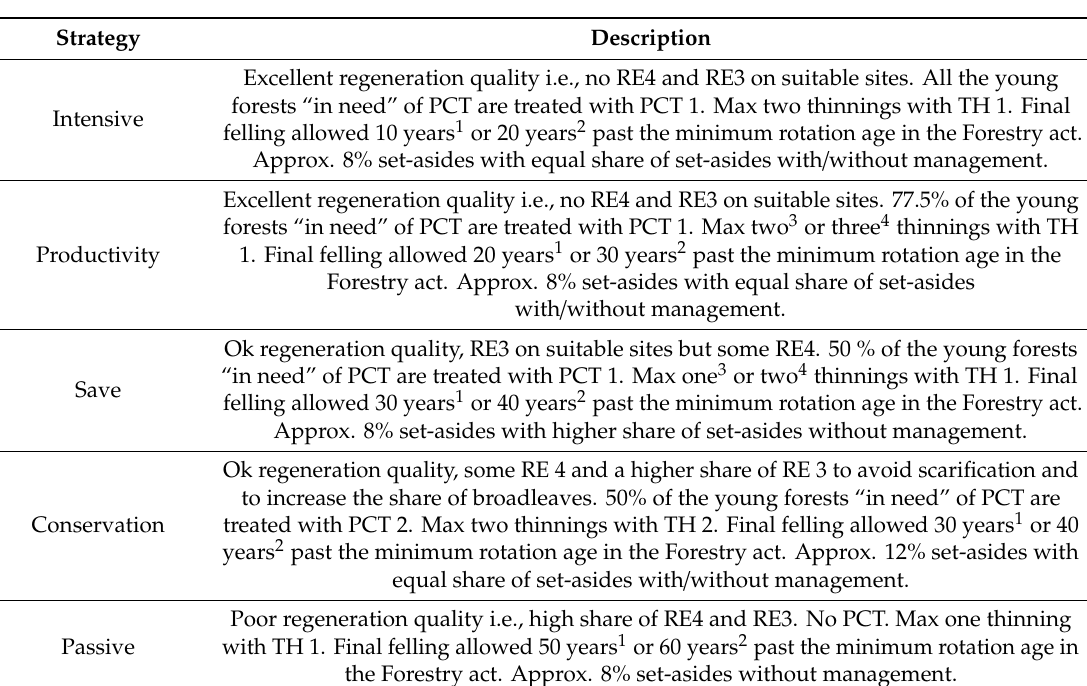
Table 3. Description of the five di ff erent forest owner